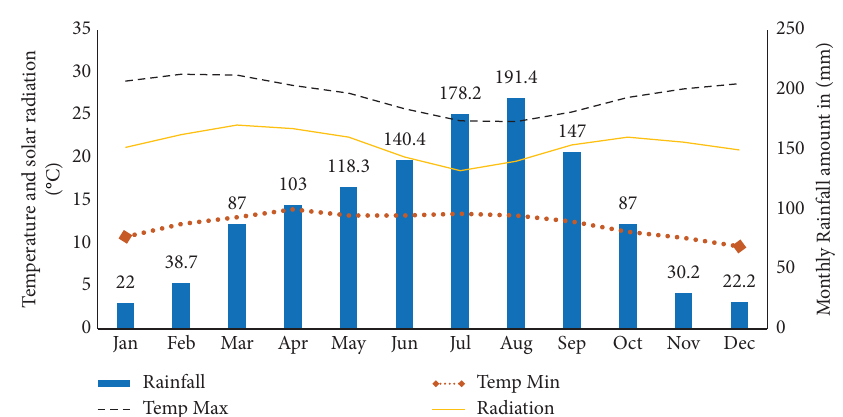
Figure 2: Mean monthly rainfall, temperature, and solar radiation of the study